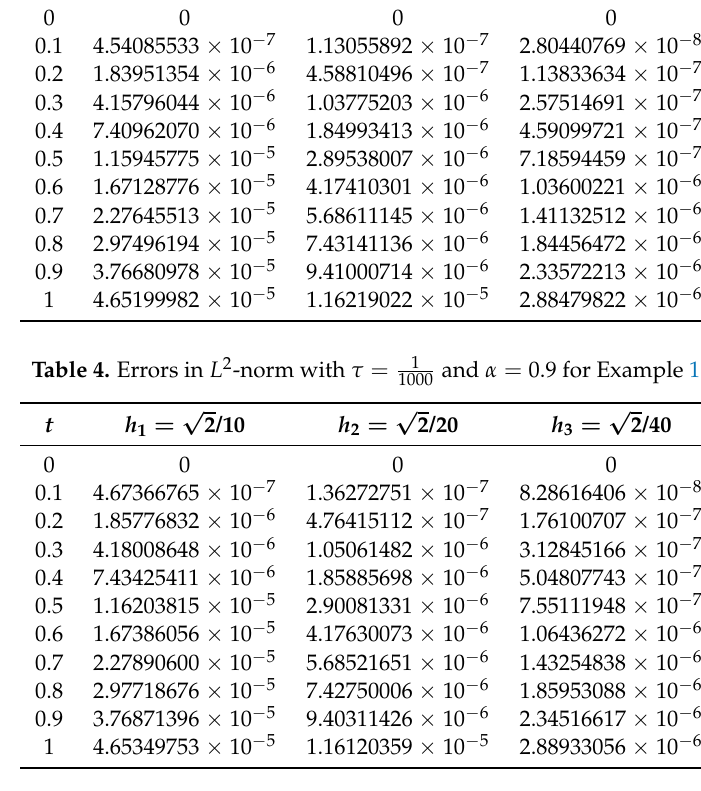
Table 3. Errors in L 2 -norm with τ = 1